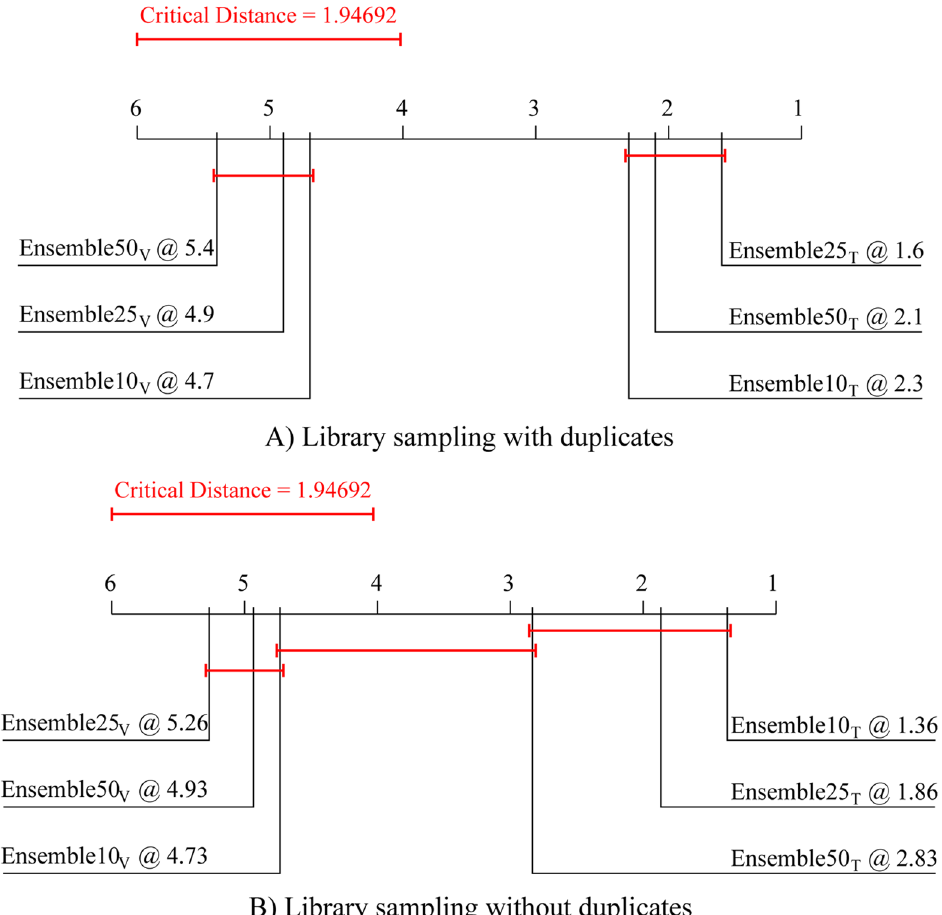
Fig 3. Comparison of the average ranks for descriptive performance (on training data) of the two library sampling methods with different methods for choosing ensemble constituents. Average ranks of ensembles with 10, 25 and 50 constituents combined by averaging and selected differently (based on their train (subscript T) or validation (subscript V) performance). The average ranks refer to the descriptive model (training) performance averaged over the 15 experimental data sets, separately for the case of Library sampling (A) with and (B) without